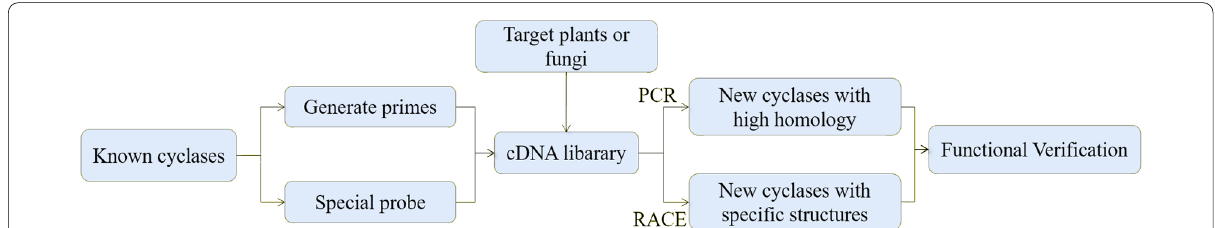
Fig. 3 Direct cloning to discover new terpene